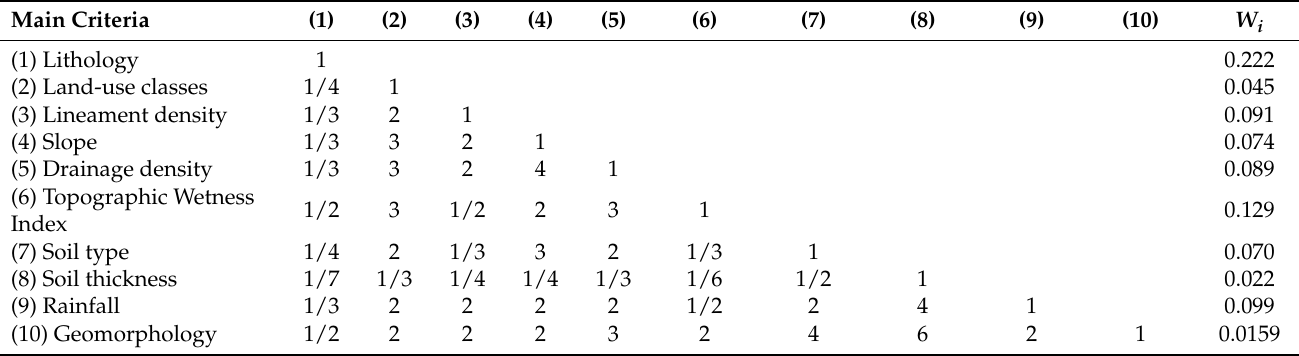
Table 4. The pairwise comparison matrix and normalised weight ( w i ) of the main selected criteria.